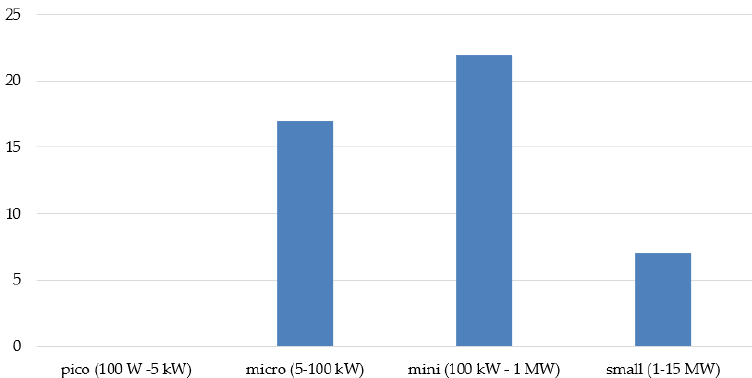
Figure 4. Distribution of hydropower systems size: Number of case studies per size range.